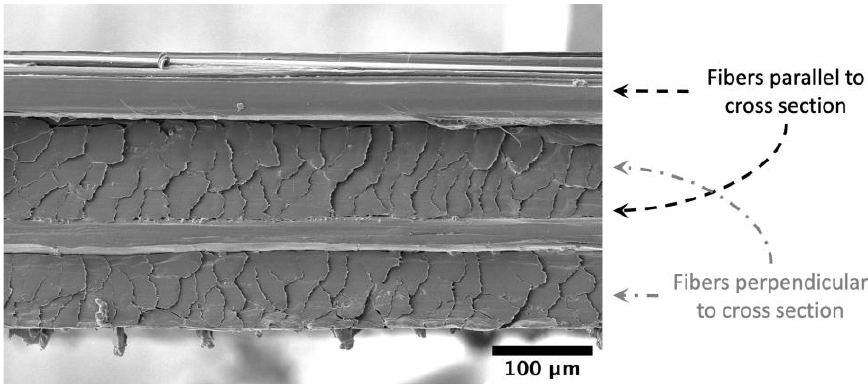
Figure 3. A typical cross-section of the UD laminate using scanning electron microscopy